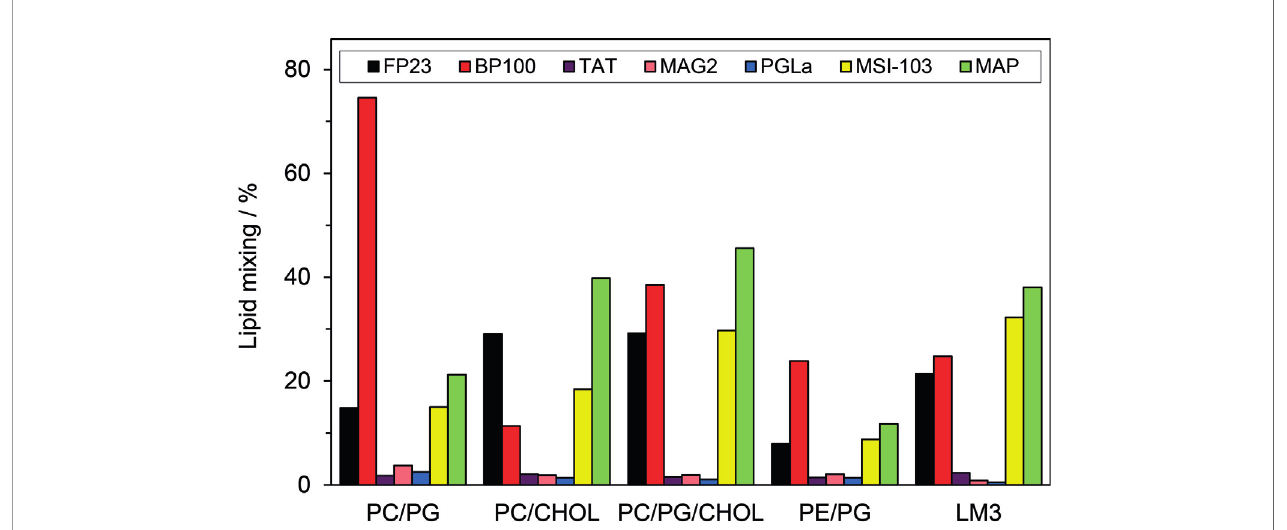
FIGURE 4 | Extent of lipid vesicle fusion induced by BP100, HIV-TAT, and the long amphiphilic helical peptides PGLa, MAG2, MSI-103 and MAP; the fusion peptide FP23 from HIV-1 is used as a control. Vesicles with the following lipid compositions were used: POPC/POPG (molar ratio 4:1), POPC/CHOL (7:3),